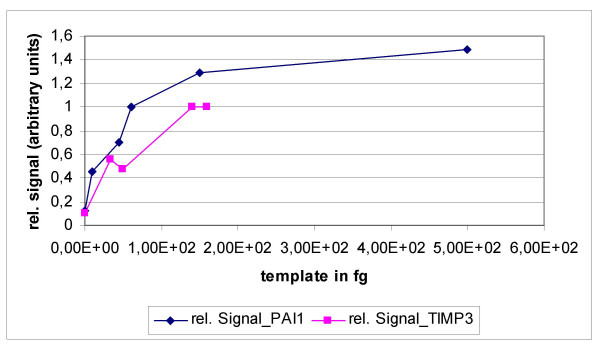
Relative hybridization signal intensity on the array vs. the absolute gene expression level. The absolute amounts of TIMP3 cDNA and PAI-1 cDNA were determined by QRT- PCR measurements. These values are presented versus the relative hybridization signals on the array.